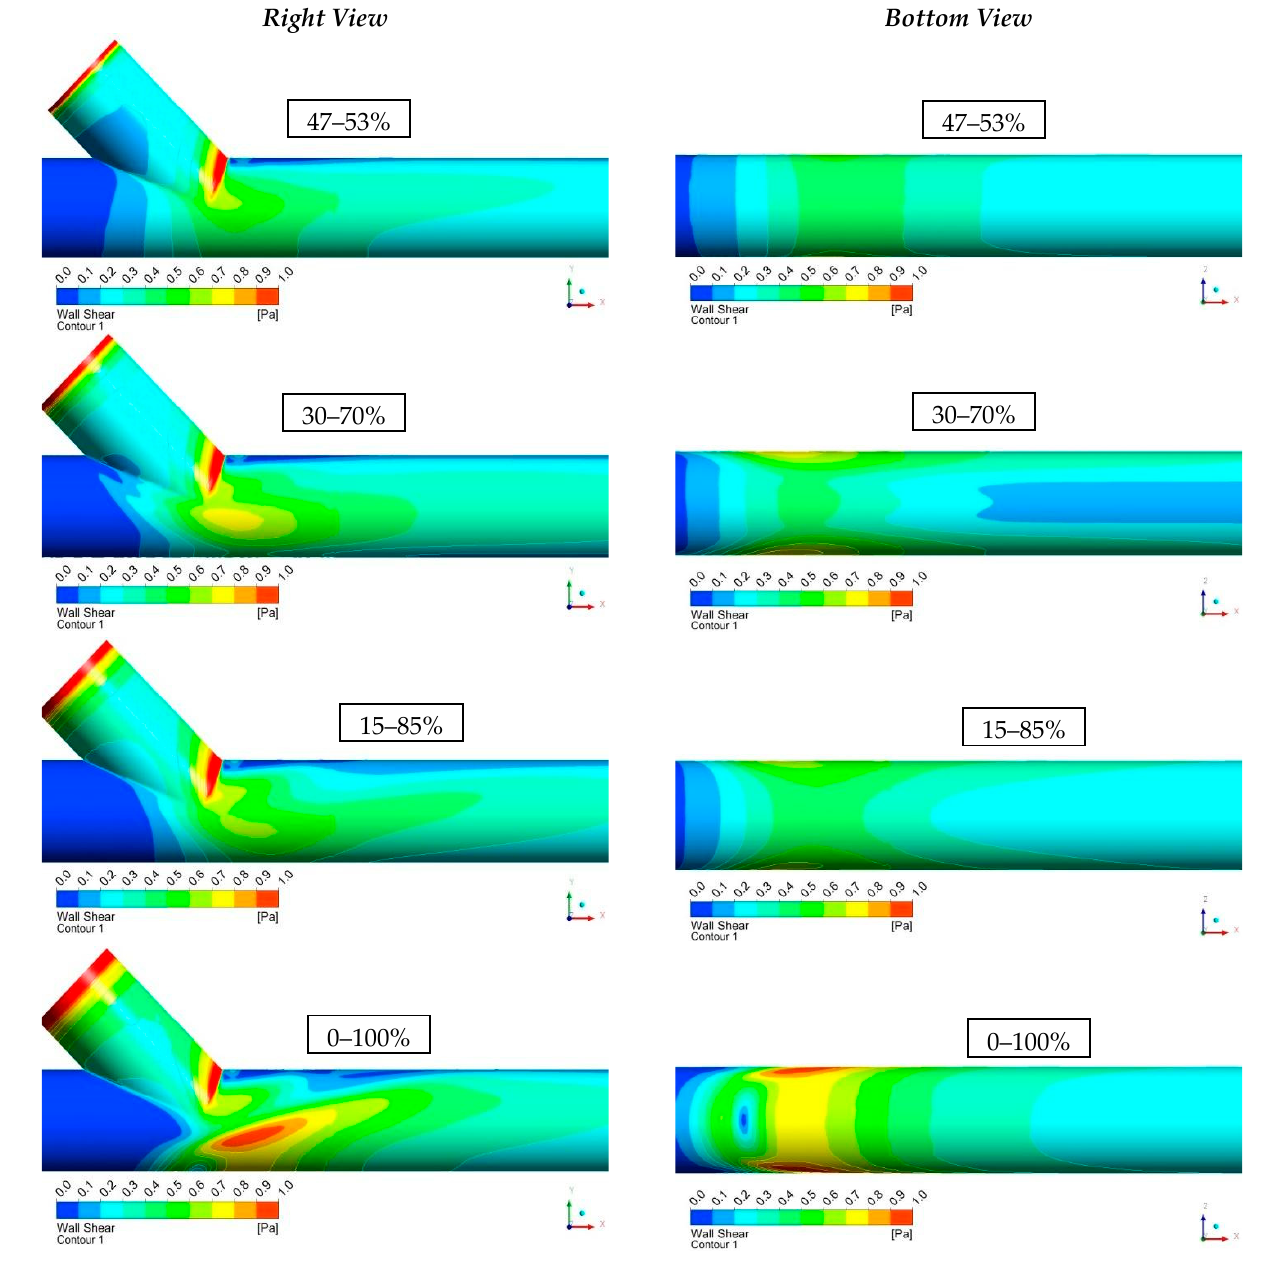
Figure 14. Results of Shear Stresses on the Vessel Walls (WSS).